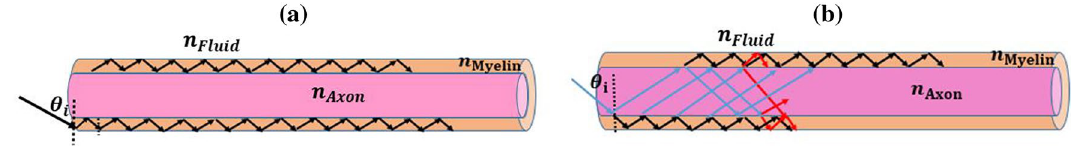
Figure 3. Schematic view of myelinated axons, ( a ) TIR in myelin sheath under conditions n Axon < n eff < n and ( b ) myelinated axons as FPR under condition n Fluid < n eff < n Myelin